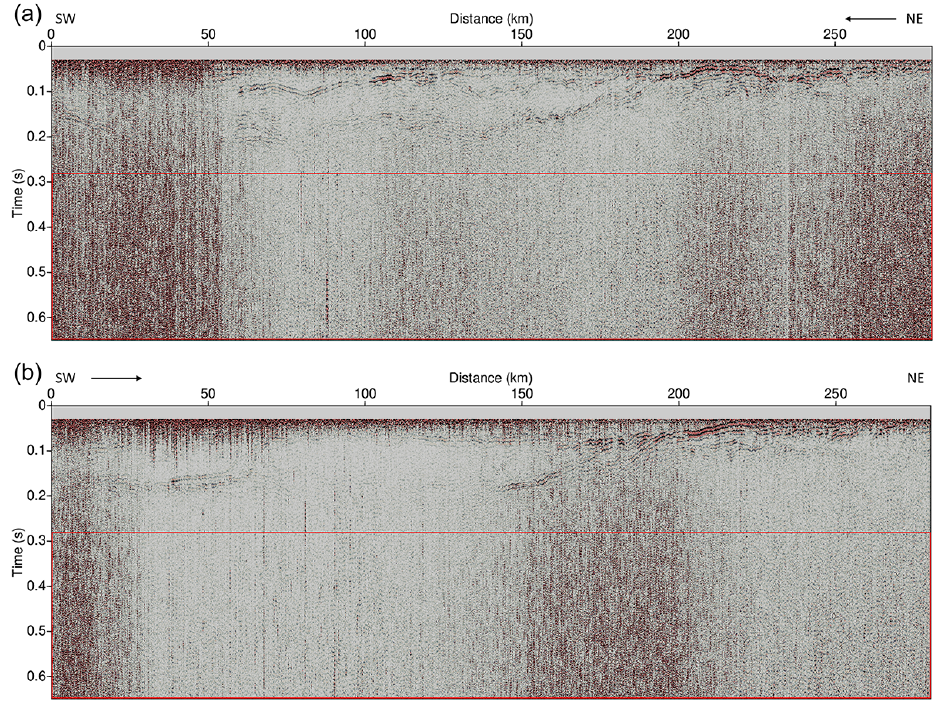
Figure 3. Processed seismic section: (a) line 1 and (b) line 2. The seismic section in the red rectangle is the noisy part used to generate the training data. SW indicates southwest, NE indicates northeast, and the black arrow indicates the data acquisition direction.